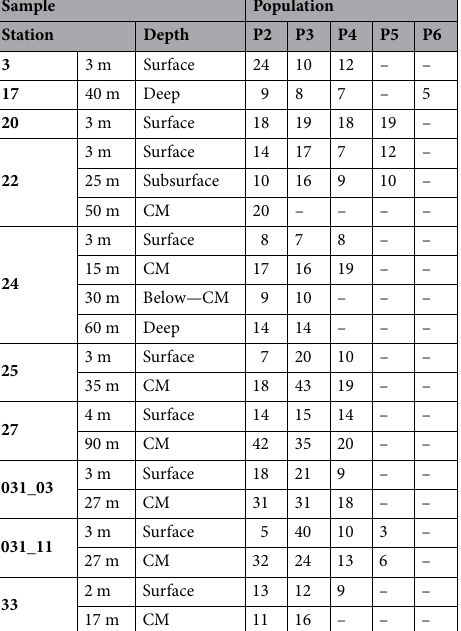
The horizontal shift in surface nutrient concentrations among habitats was too modest to affect the relative contribution of small pigmented eukaryote to total small phytoplankton abundances, contrary to reports for much larger spatial scales involving greater differences in nutrient concentrations, ranging from coastal systems to the open ocean 10,16 . Small photosynthetic eukaryote abundance and biomass were not significantly correlated